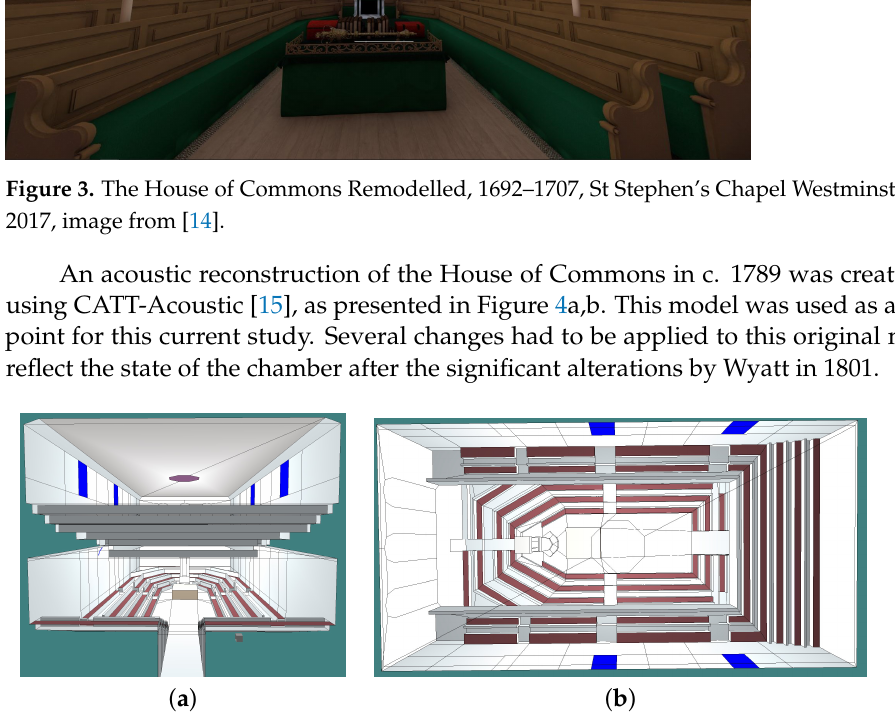
Figure 4. The original version of the model in CATT-Acoustic by [4], representing the House of Commons in c. 1789: ( a ) Section from north to south where the main entrance of the House of Commons was. ( b ) An elevation view of the